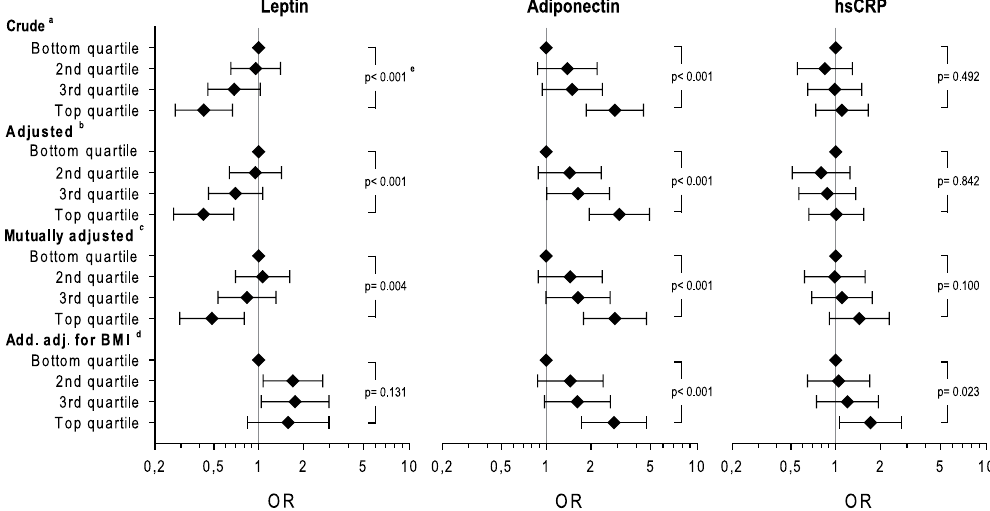
Figure 1. Adjusted Odds Ratios (ORs) for ALS with sex specific quartiles of leptin, adiponectin and CRP serum concentrations among 269 patients compared to respective controls. a Stratified for age and sex. b Additionally adjusted for school education, occupational work intensity, smoking (ever), family history of ALS. c as b but mutually adjusted for leptin, adiponectin and hs-CRP. d as c but additionally adjusted for Body mass index (BMI). e P-values indicate trend over quartiles.